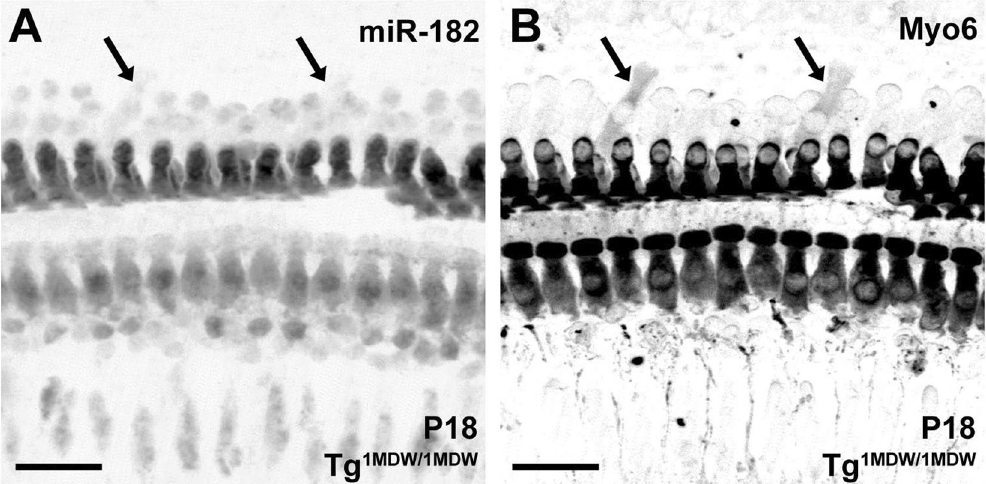
Figure 3. Deiter’s cell expression of MYO6 in P18 Tg 1MDW/1MDW OC, an early marker of differentiated HCs. ( A ) MYO6 staining in OC whole mount showing definitive label in Deiter’s cells (black arrowheads). ( B ) miR-182 co-staining. MYO6 is a marker of HC differentiation, suggesting that miR-183 cluster misexpression and its cytoplasmic localization are positive effectors of HC identity. Scale bar: 20 μ M ( A , B